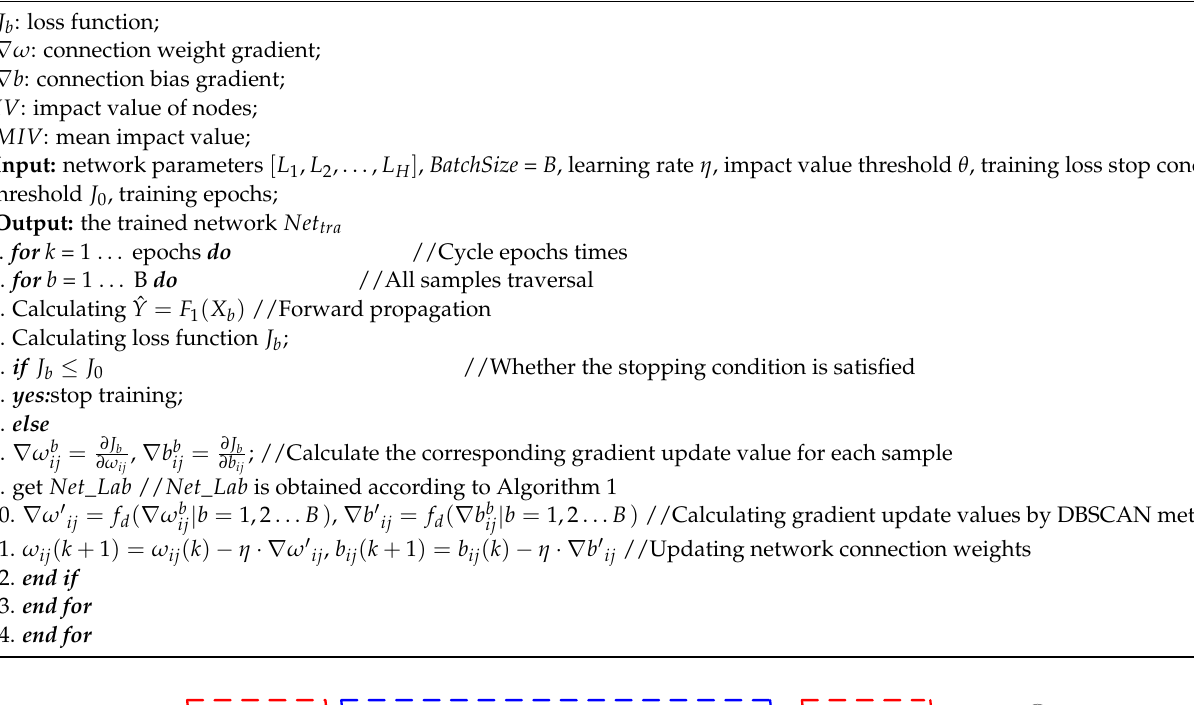
Algorithm 2: Sparse denoising gradient decent optimization algorithm